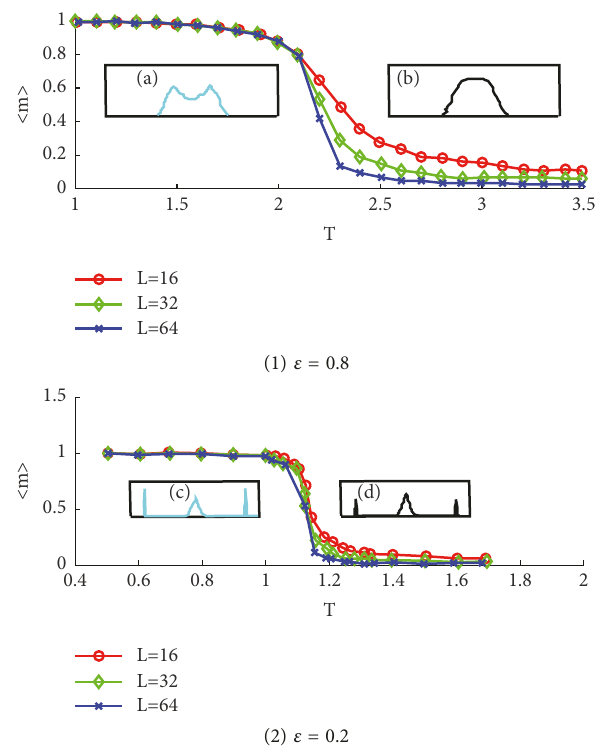
Figure 6: Order parameter changes with temperature (the illustra- tion shows the distribution of probability density functions of order